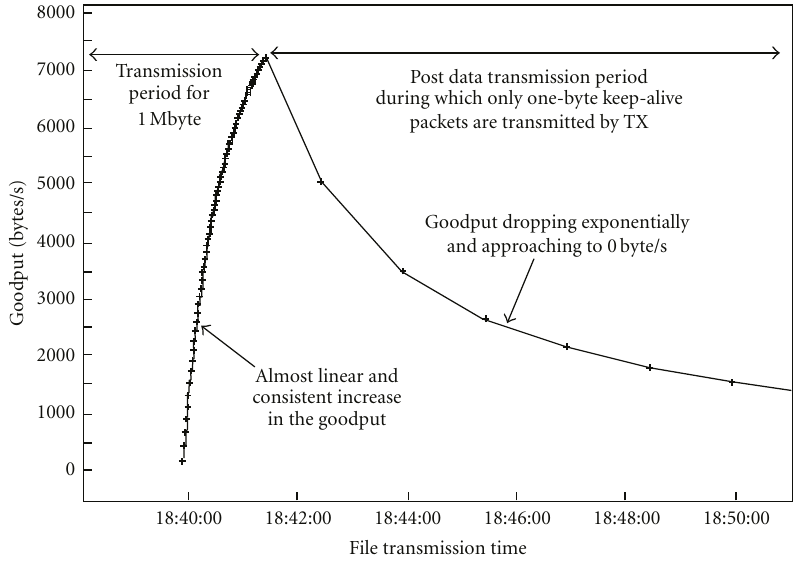
Figure 5: Goodput trace for DTN transmissions of 1 Mbyte from TX to MX.